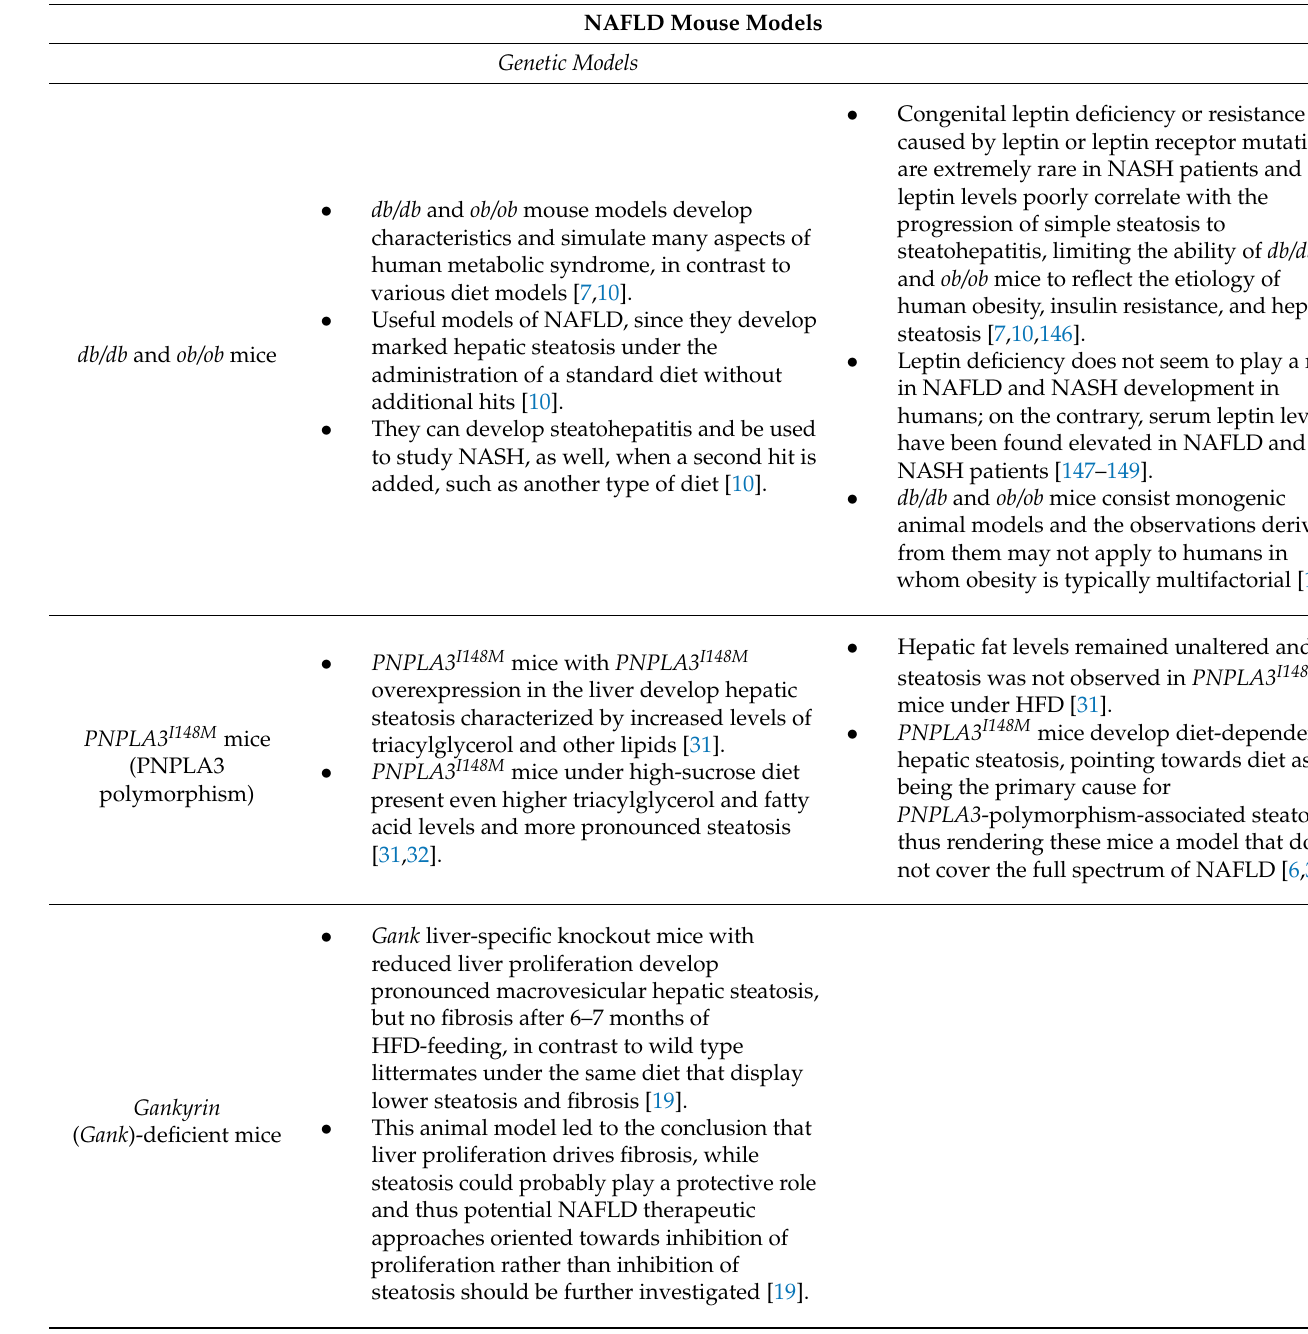
Table 1. Cont . Advantages Disadvantages NAFLD Mouse Models Genetic